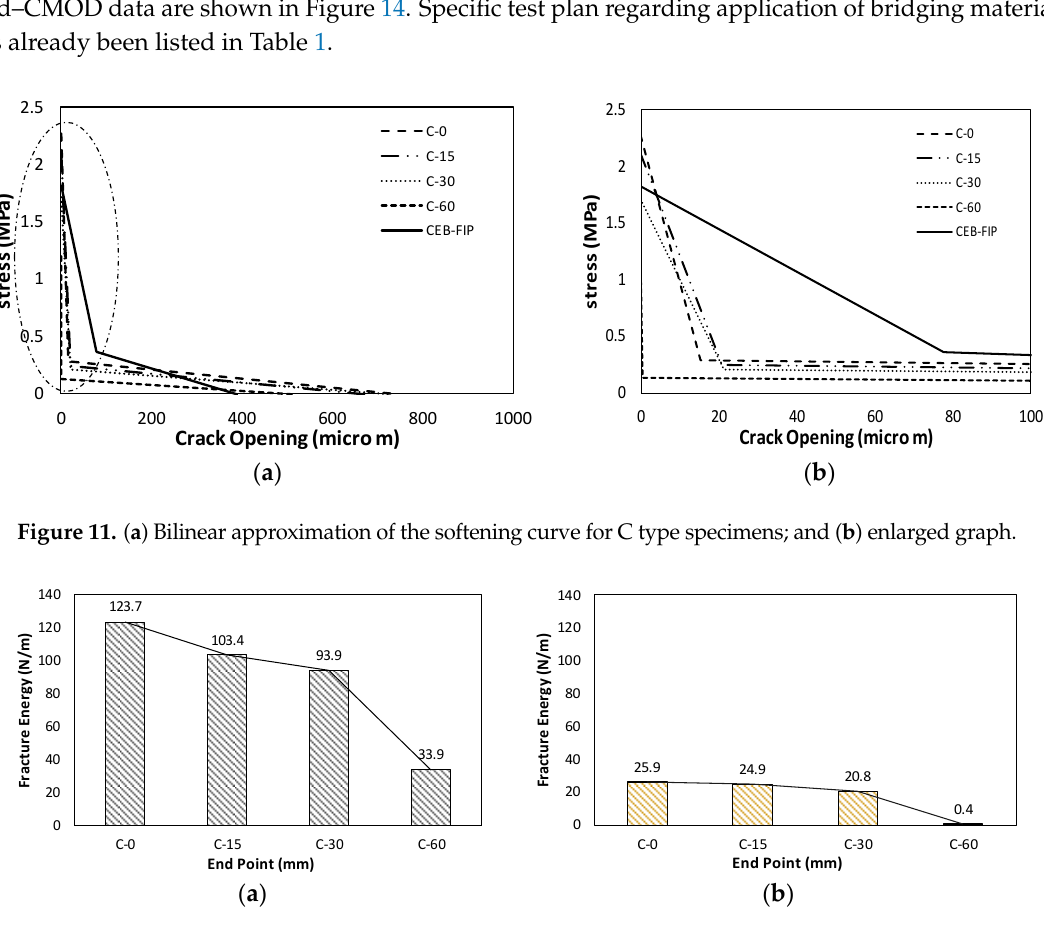
( b ) Figure 10. ( a ) Obtained results for far tail constant, A ; and ( b ) critical crack opening displacement, Wc . The experiment found the longer the elapsed time to meet a new layer (accumulation time), the smaller the maximum crack width ( w c ) and far tail constant ( A ). This might cause structural integrity reduction and structural performance decrease, particularly shear capacity. The final bilinear stress-crack opening displacement is shown in Figure 11 with a bilinear graph based on CEB-FIP (2010) [23]. The calculated true fracture energy ( G F ) and size effect fracture energy ( G f ) have been compared in Figure 12 and Table 2. Both true fracture energy and size effect fracture energy showed decrease in energy with elapsed time to meet a new layer. For C-15 and C-30, 16.4% and 24.1% of fracture energy decreased when compared to the C-0 specimen. However, for C-60, 72.6% decrease in fracture energy was observed.